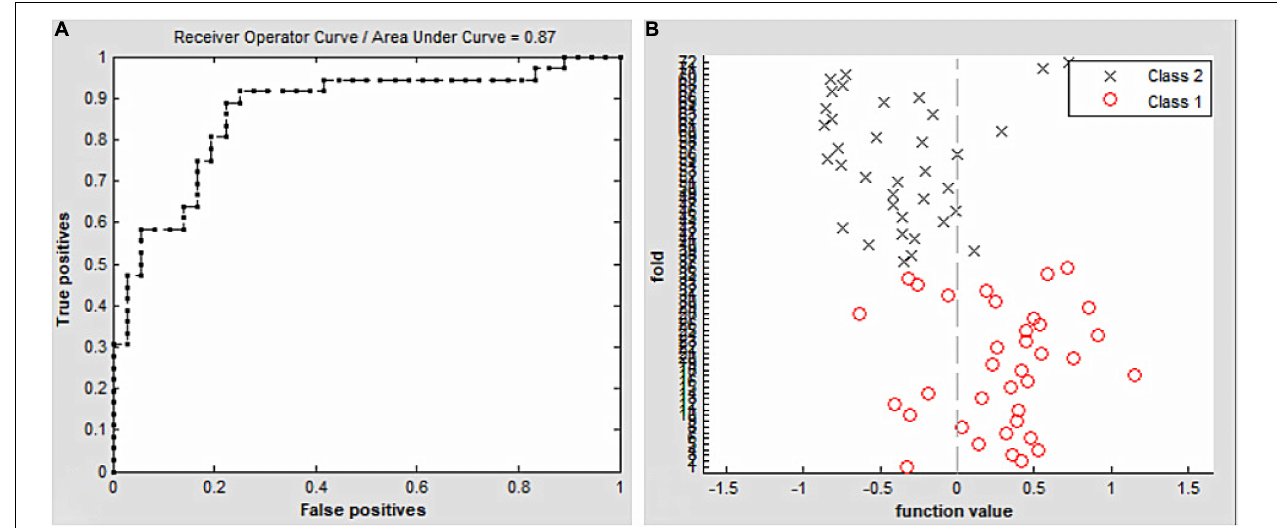
FIGURE 3 | Classification results using support vector machine (SVM) based on VMHC values. Function values of two groups (class 1: CE group; class 2: HC group); (A) . The ROC curve of the SVM classifier with an AUC value of 0.87 (B) . Abbreviations: CE, comitant exotropia; HC, health control; VMHC, voxel-mirrored homotopic connectivity; ROC, receiver operating characteristic; SVM, support vector machine; and AUC, area under the